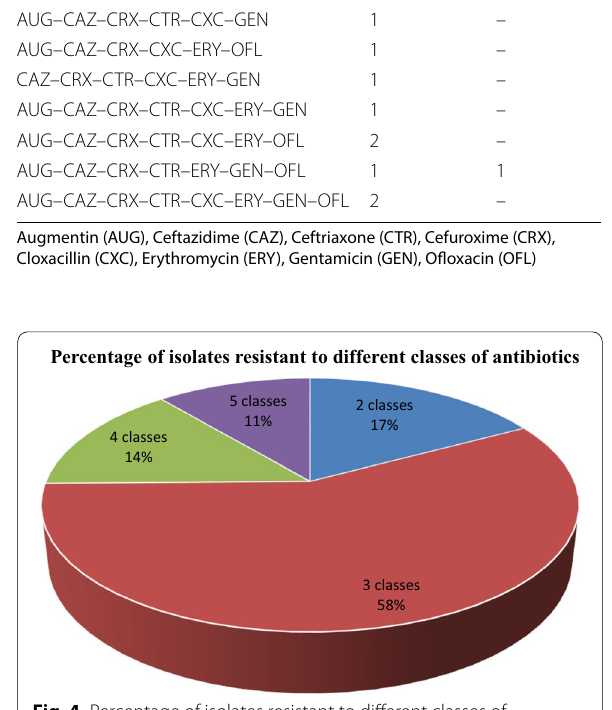
Fig. 4 Percentage of isolates resistant to different classes of antibiotics